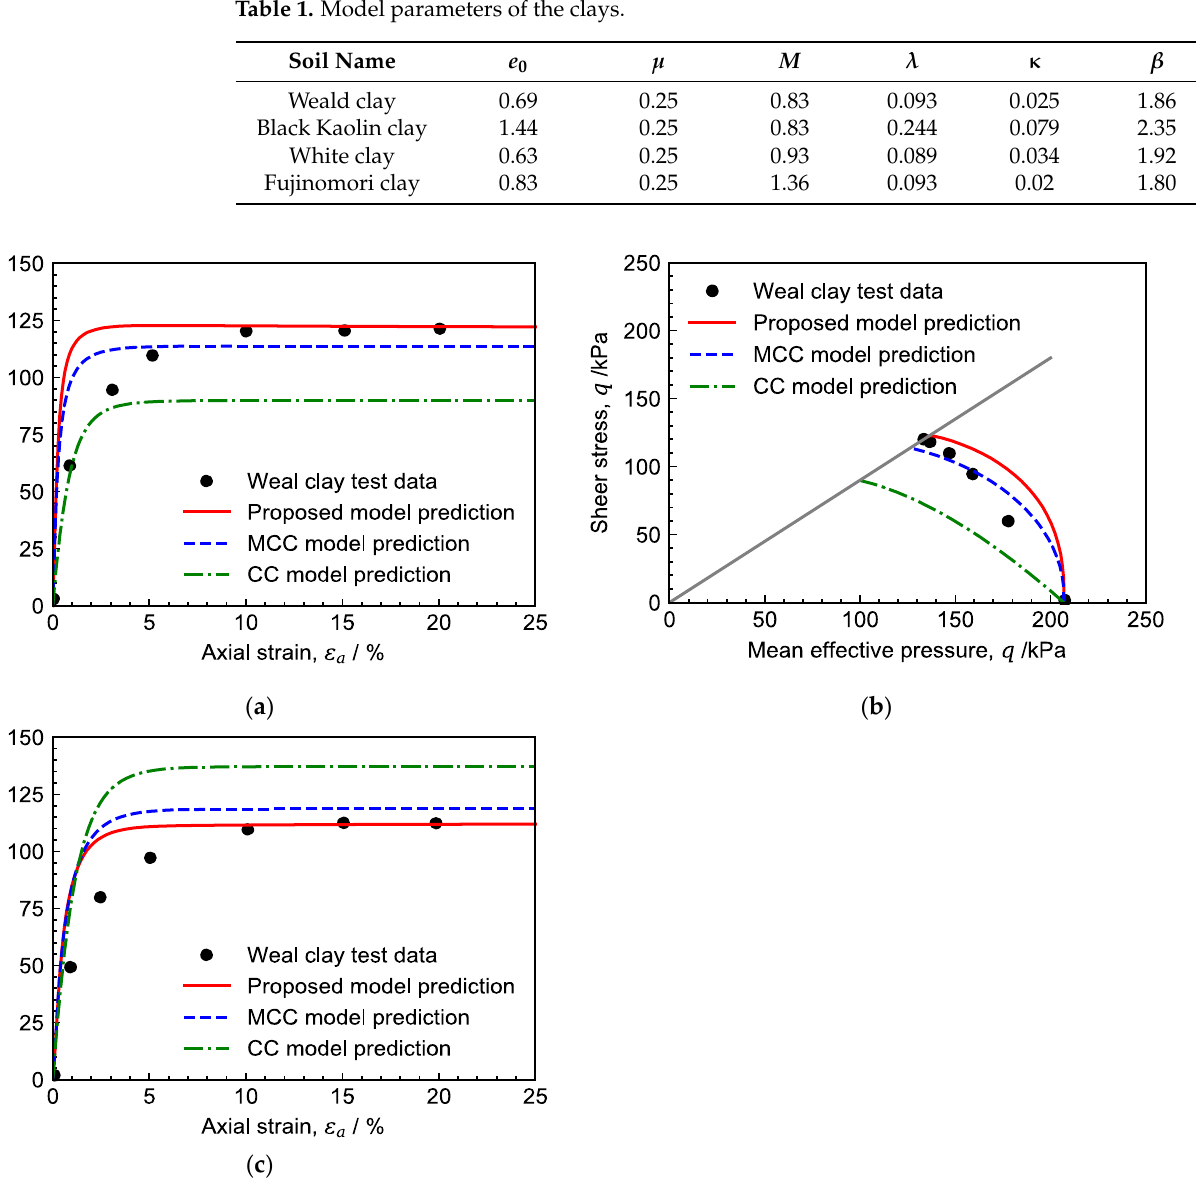
Figure 7. Comparison between the undrained triaxial test result and the model predictions on Weald clay: ( a ) the stress ratio–axial strain relation; ( b ) the stress path; ( c ) the pore water pressure–axial strain